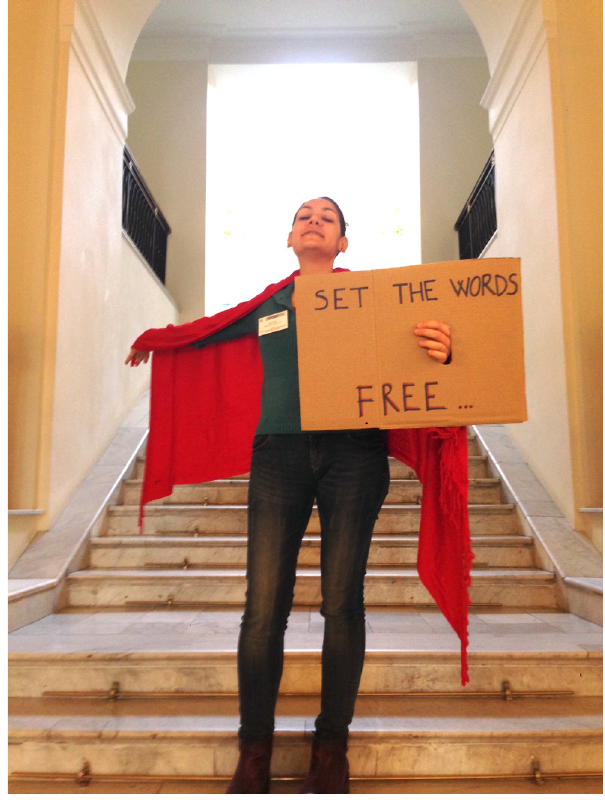
Figure 6. “Wozu Image?”: Set the words